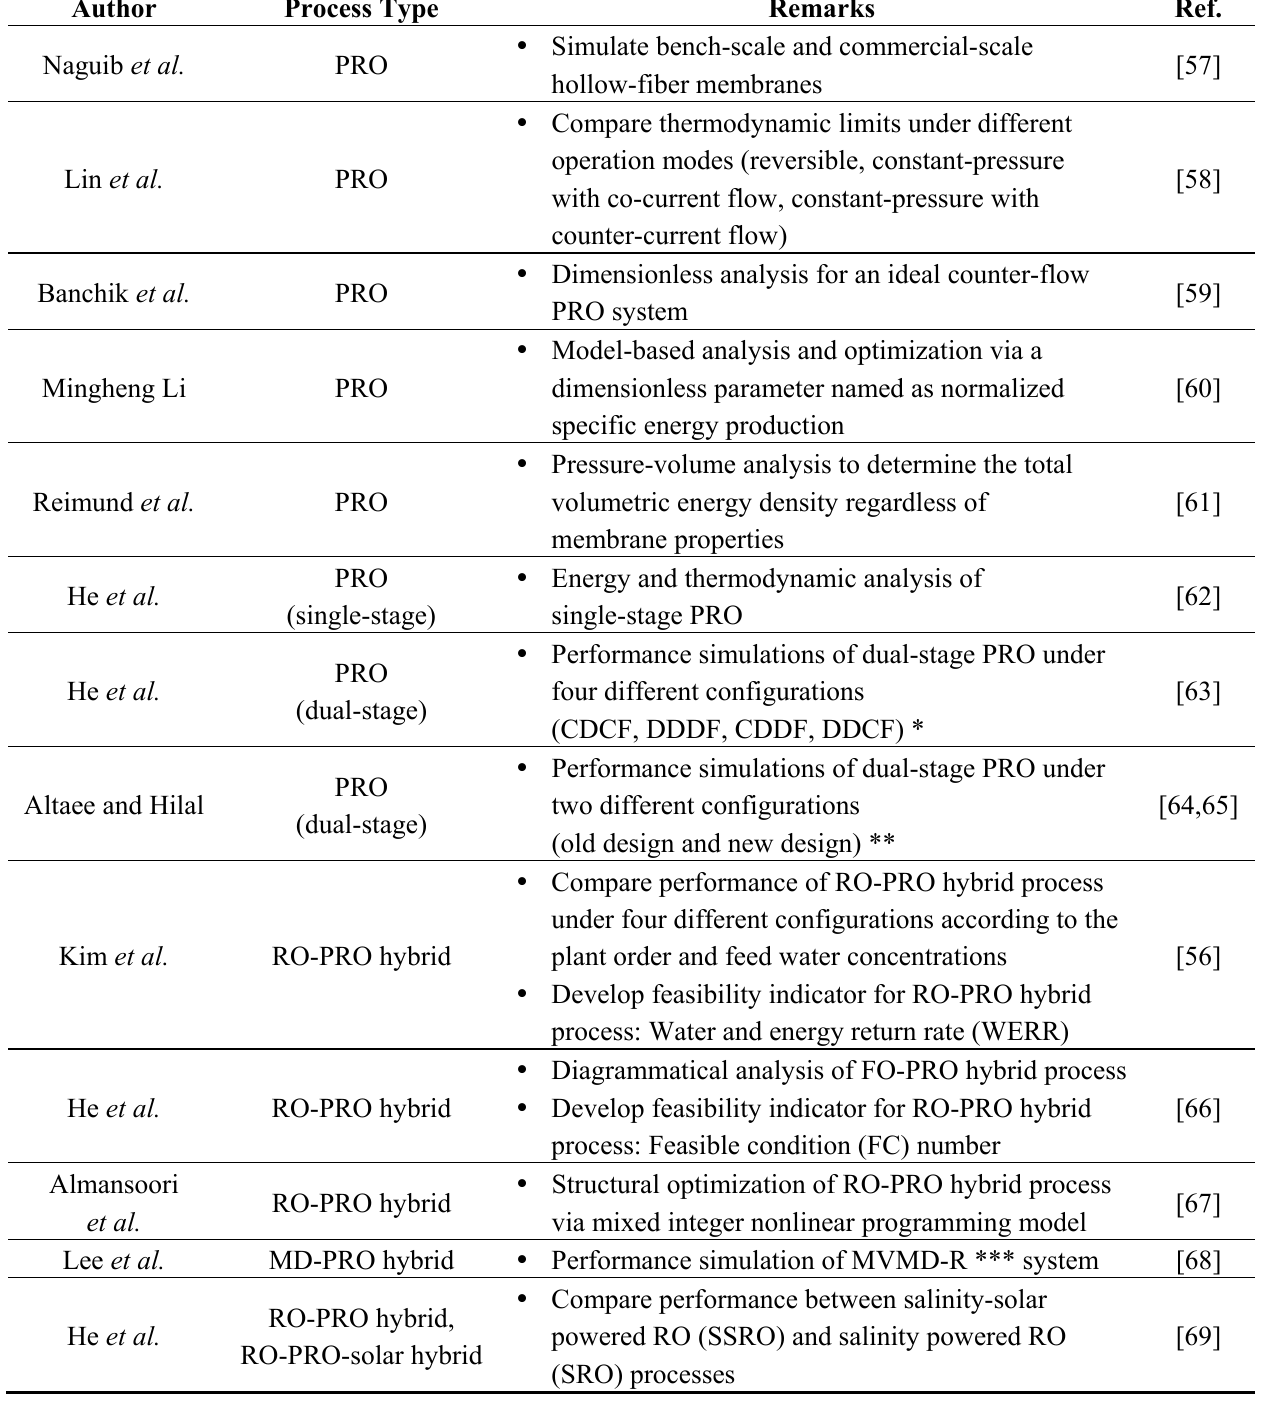
Table 4. Numerical studies of PRO and PRO-related